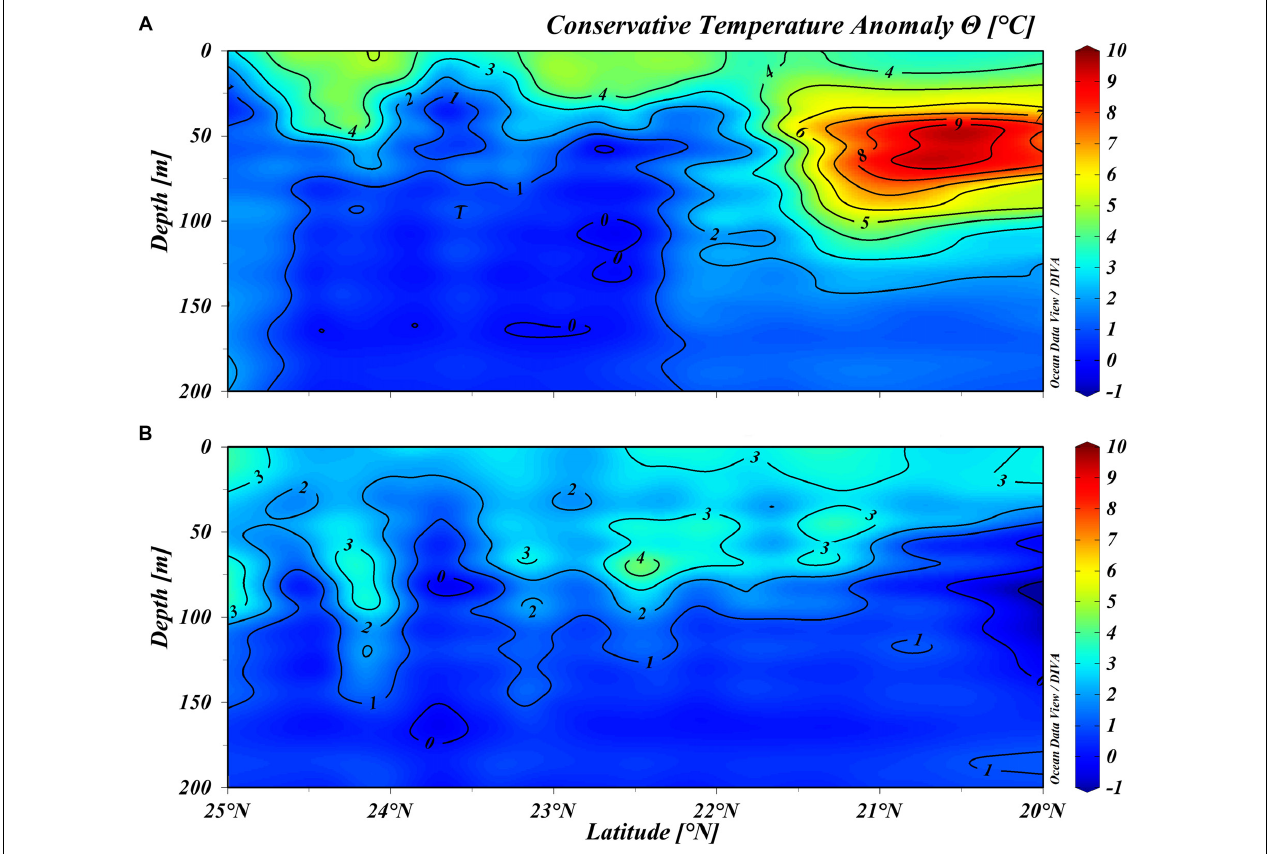
FIGURE 4 | Vertical distribution of conservative temperature ( (cid:50) , ◦ C) anomalies along transect 1 (see Figure 1 ). (A) June 2015 and (B) March 2016. Refer to text for anomaly